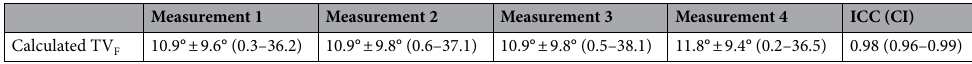
Table 4. For intra-observer reliability analyses, four measurements of one observer of calculated TV F were compared using the ICC. Measurements are demonstrated as mean ± SD and range. The ICC is shown with the 95% confidence interval (CI).